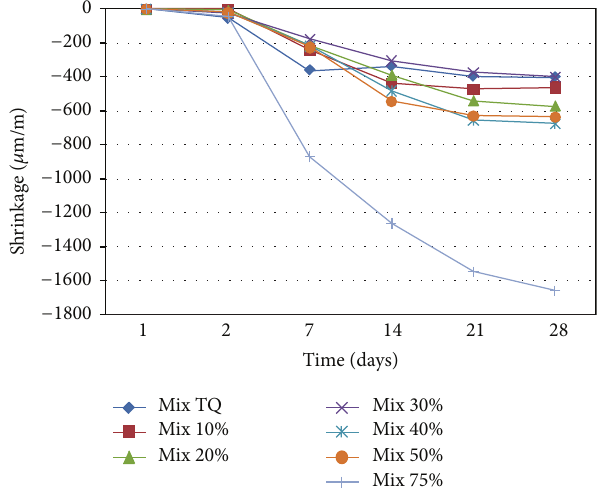
Figure 11: Shrinkage for rubber cement composites at 1, 2, 7, 14, 21, and 28 days.